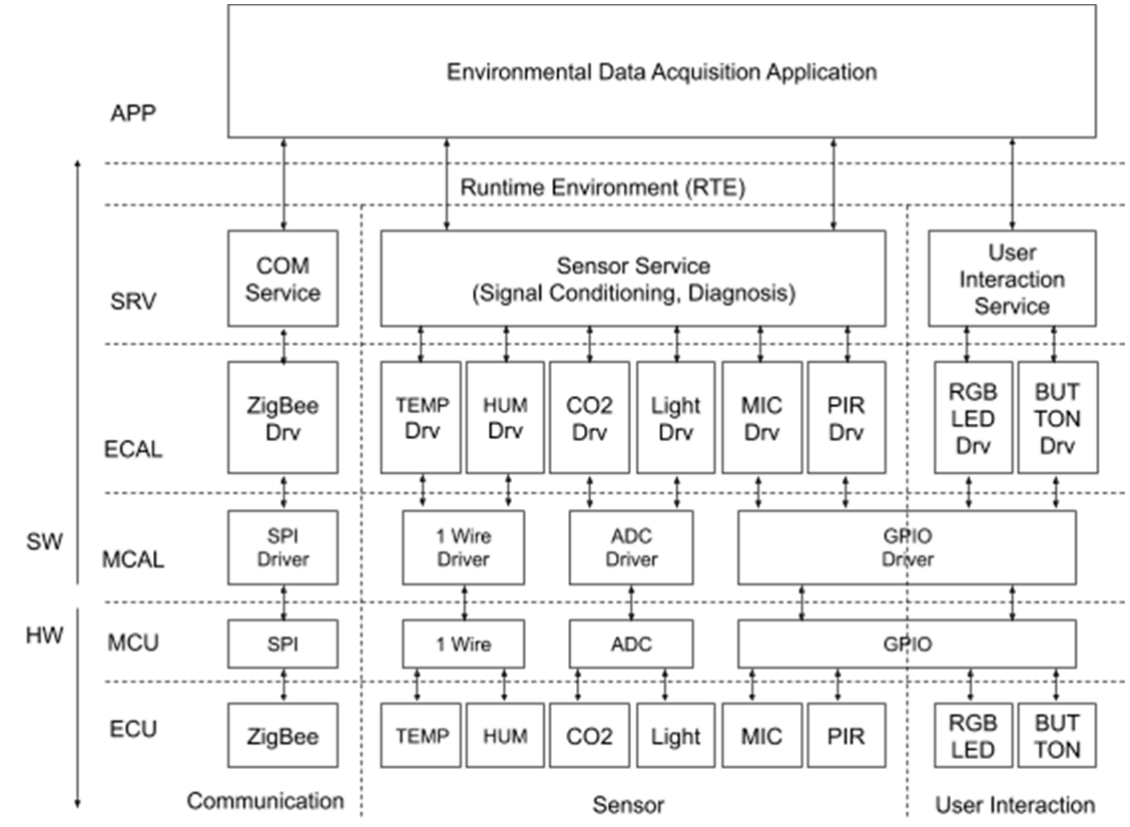
Figure 8. Layered architecture of the IoT